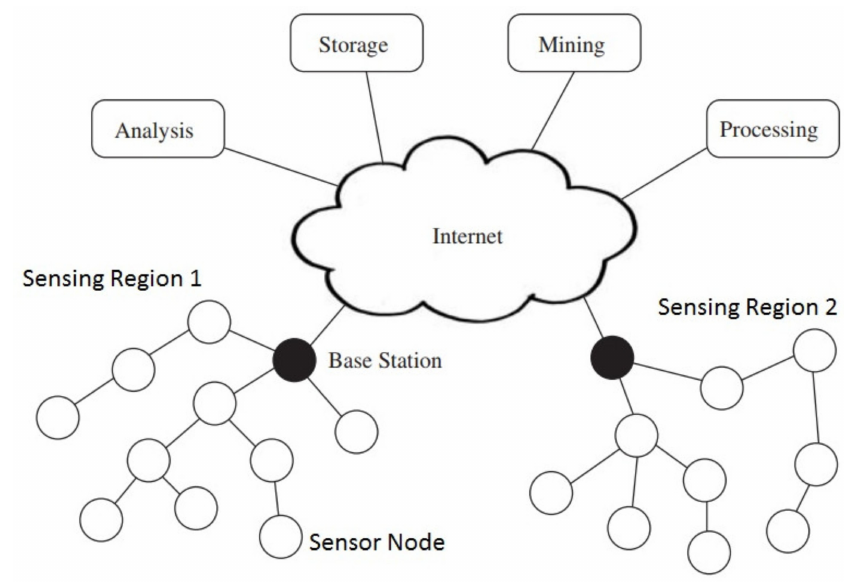
Figure 2. Fifth-generation-based WSN architecture